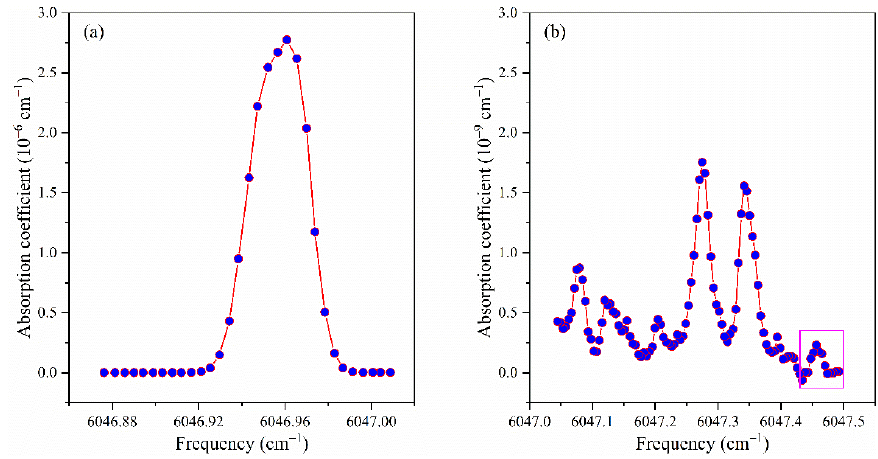
Figure 10. Spectral measurements around ( a ) 6046.95 cm −1 and ( b ) 6047.30 cm −1 , with an estimated CH 4 partial pressure of 0.1 pa. The vertical scale of ( b ) is 1000 times smaller than that of ( a ).